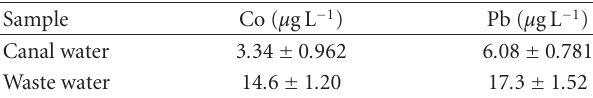
Table 4: Determination of lead and cobalt in water